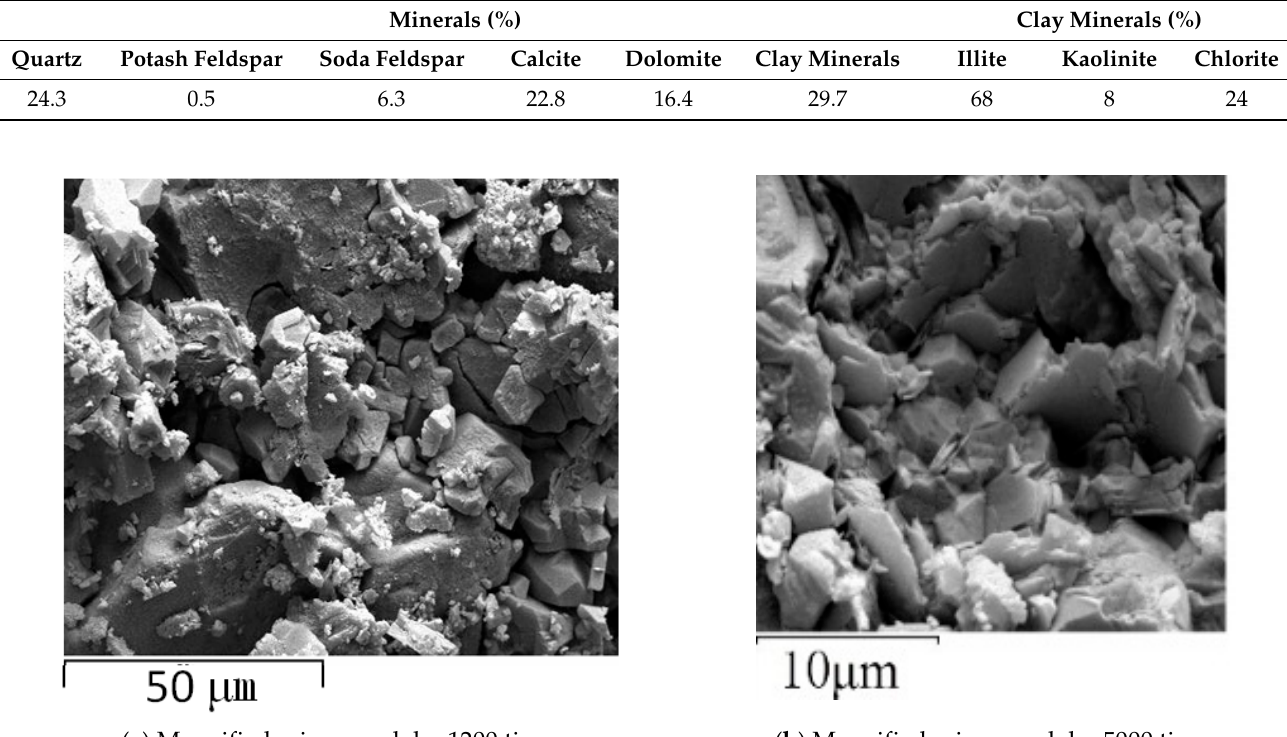
Table 1. XRD experimental results of sandstone samples.